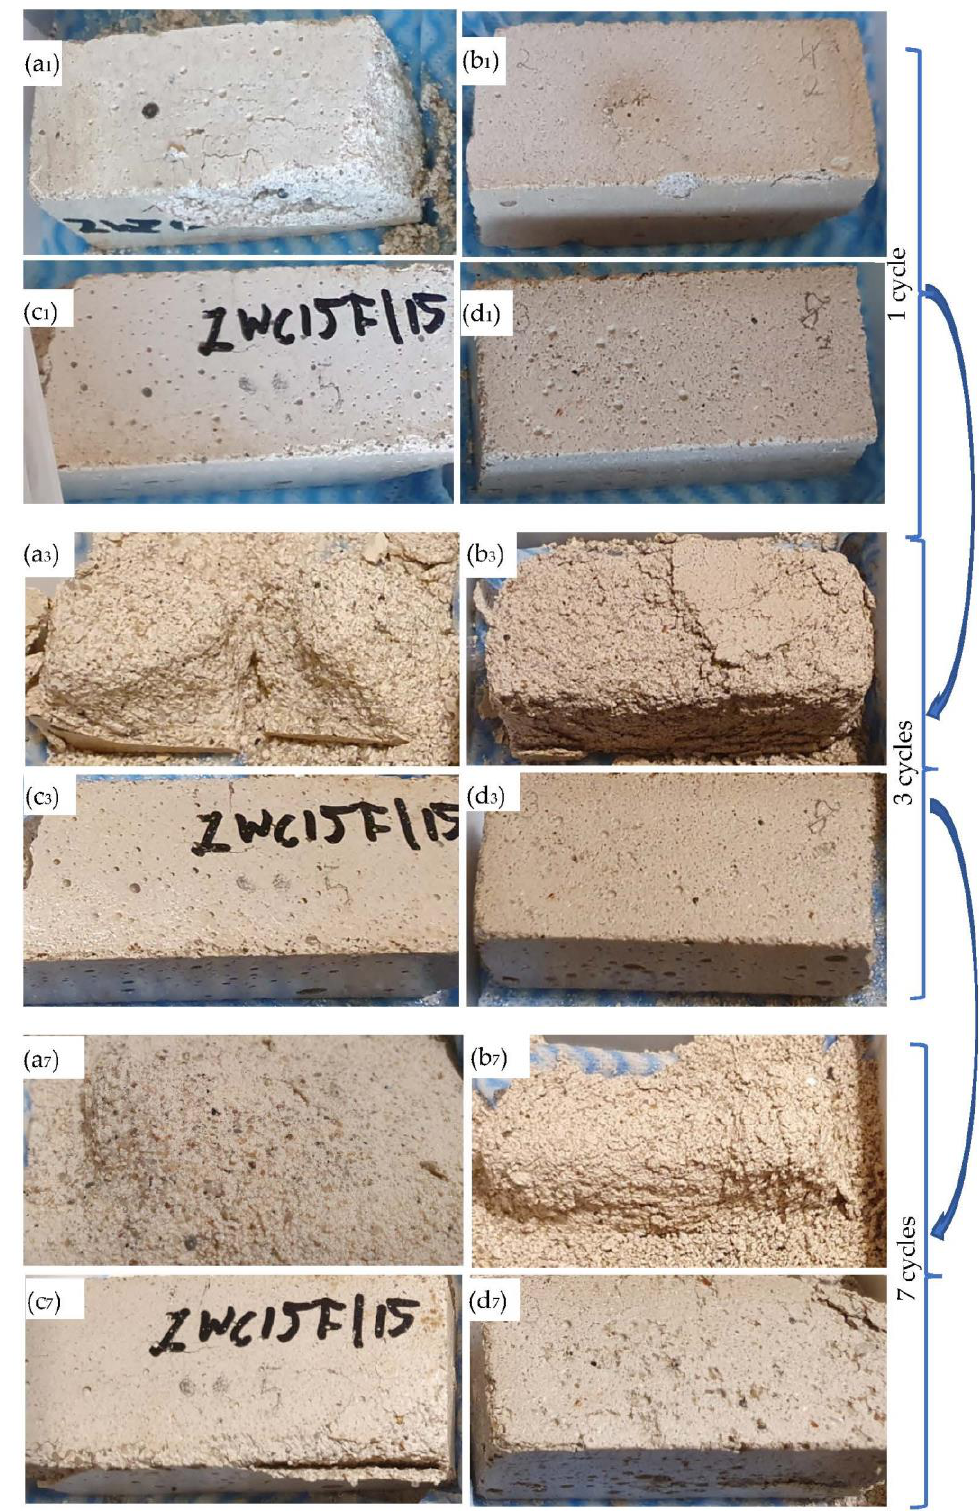
Figure 5. General view of lime mortar specimens after 1, 3 and 7 cycles of water – frost resistance test: ( a 1,3,7 ) M0; ( b 1,3,7 ) F30; ( c 1,3,7 ) C15F15; ( d 1,3,7 ) C30F30.